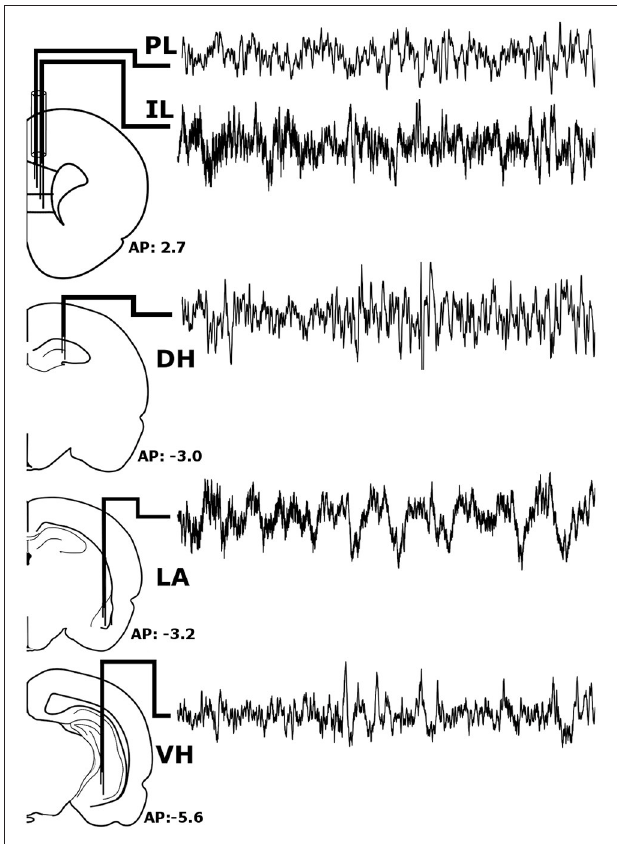
FIGURE 1 | Stereotaxic Implantation. Bipolar electrodes were chronically implanted in the pre-limbic and infra-limbic prefrontal cortex (PL; IL), dorsal and ventral hippocampus (DH; VH), and the lateral amygdala (LA) to record local field potentials. The raw signals pictured above were recorded simultaneously from a single animal during wakefulness and represent roughly 6s of recording